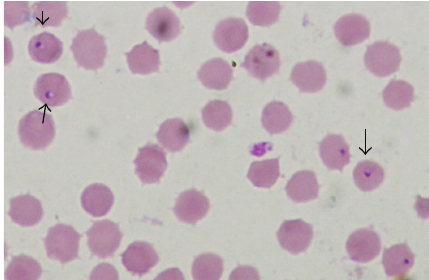
Figure 1: Blood smear stained with Giemsa stain demonstrating intracellular trophozoite “signet ring” of Theileria annulata ( × 100) (arrows).